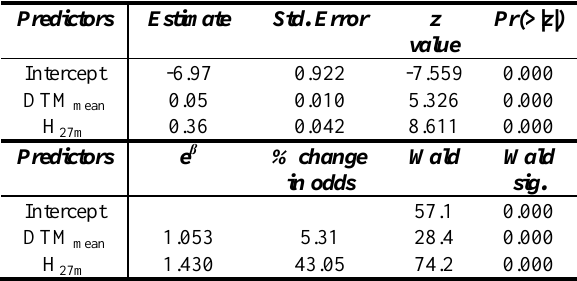
Table 2. Parameters and fit statistics for the logistic regression model with mean elevation (DTM mean ) and mean height around sample plots (H 27m ) as predictor